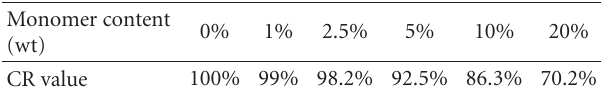
Table 1: Contrast ratio for a pixel as determined from the trans- mission of the UV/VIS